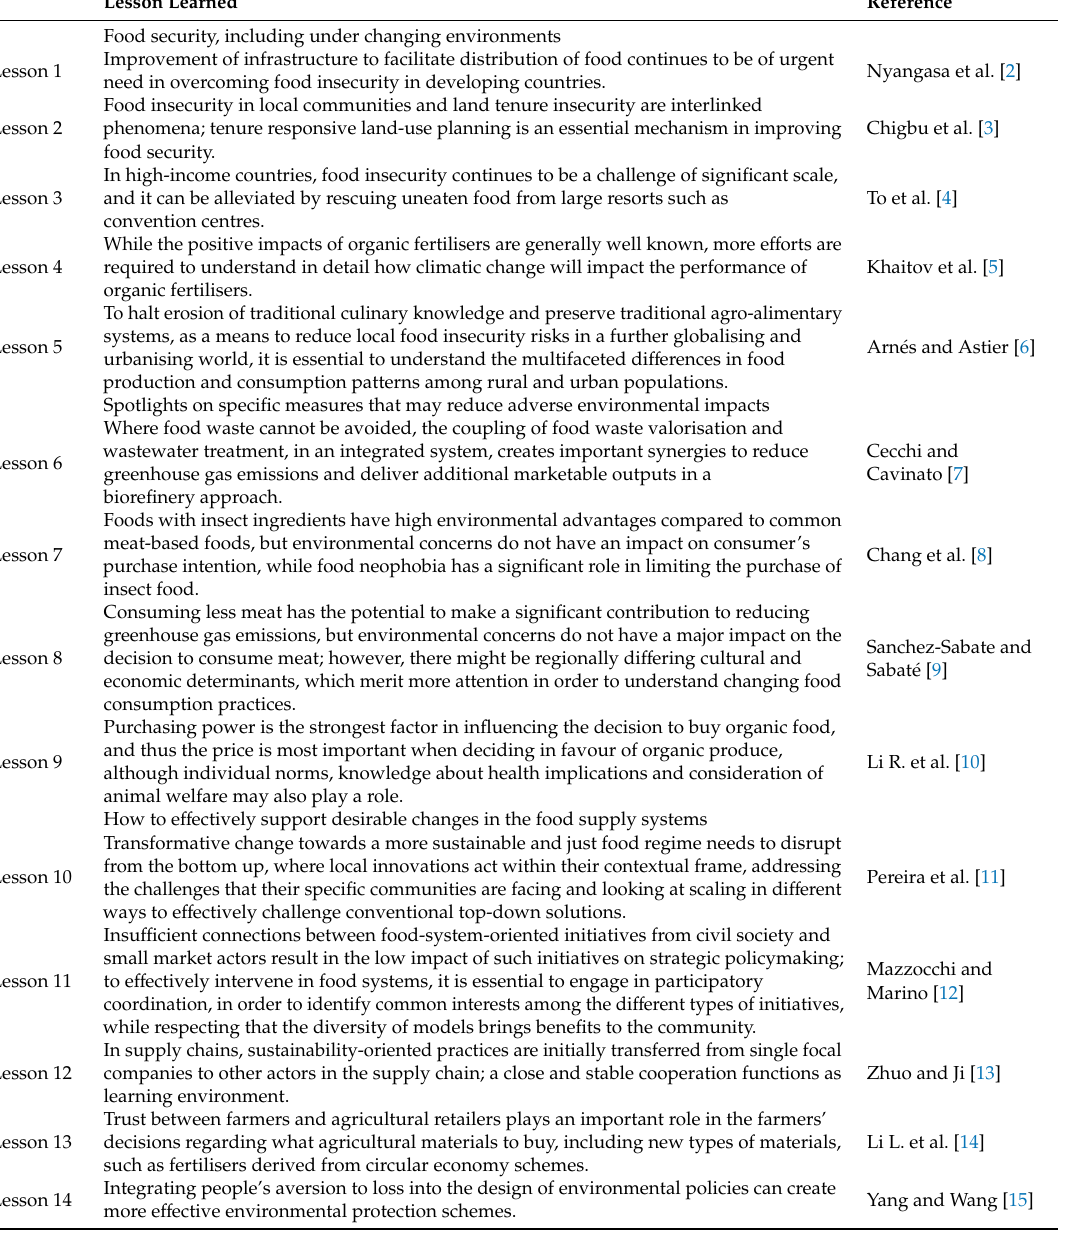
Table 2. Overview of 14 insights extracted from the publications of the Special